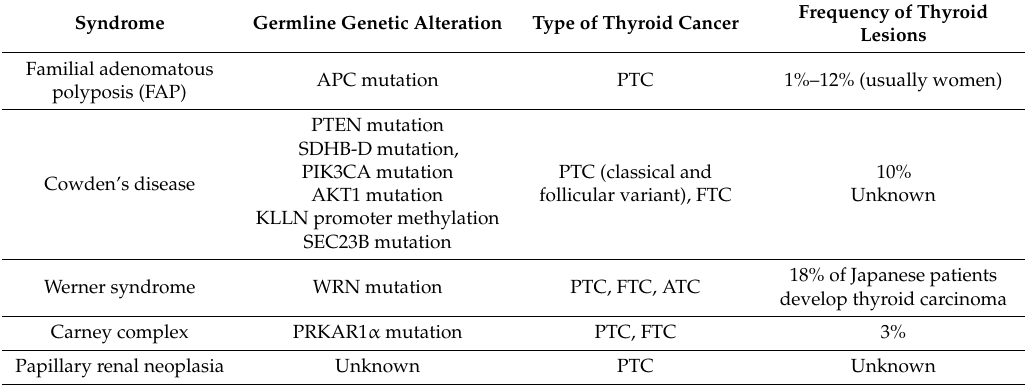
Table 1. Syndromic familial non-medullary thyroid cancer (NMTC). (Data from Yang et al. 2016, Vriens et al. 2009, and Gri ffi th et al.